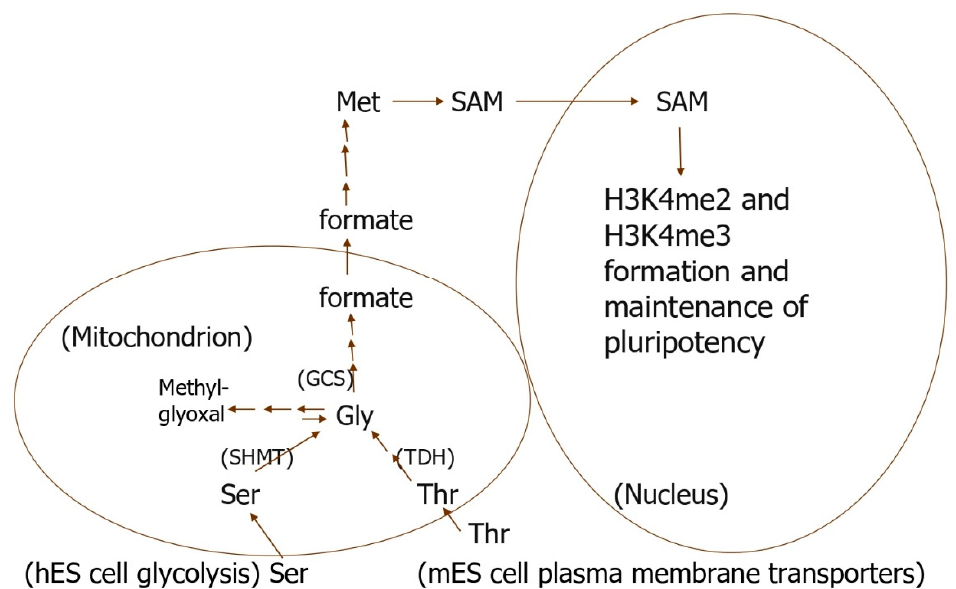
Figure 1. Mouse and probably most other mammalian ES cells require threonine (Thr) for the production of the 1C units needed to methylate histone H3K4. H3K4me3 formation is needed to maintain ES cell proliferation and pluripotency. Since other sources of 1C units cannot substitute Thr, we propose that a subpopulation of perinuclear mitochondria take up Thr, use it to form formate, and then selectively direct the formate to produce the S-adenosylmethionine (SAM) used in the nucleus to methylate H3K4. Since hES cells produce an inactive form of threonine dehydrogenase (TDH), they upregulate the expression of serine (Ser) synthesis enzymes probably to produce 1C units for H3K4me3 formation. GCS, glycine cleavage system; SHMT, Serine hydroxymethyltransferase. (The figure is a modification of those in reference [1]).